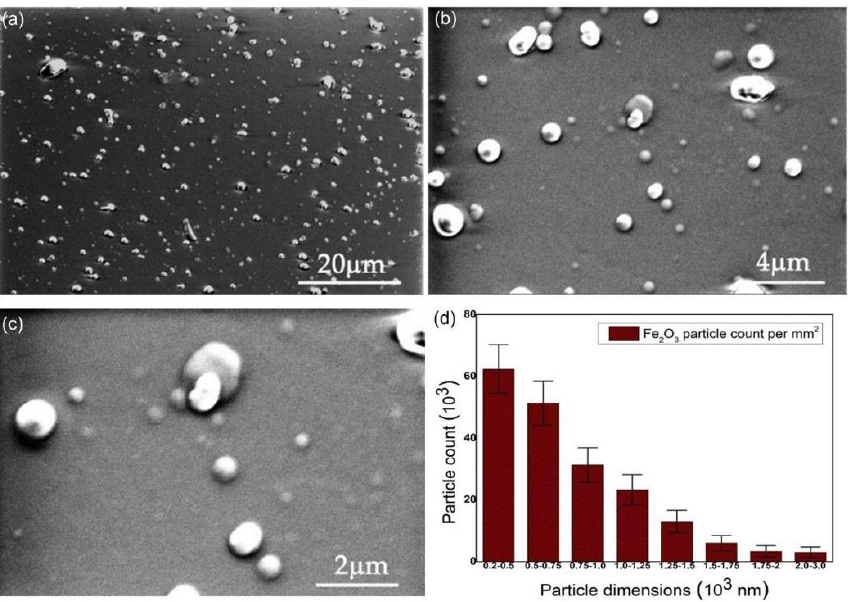
Figure 2. SEM images of PANI-IO film obtained by DC plasma polymerization at: ( a ) 2500×, ( b ) 10,000×, ( c ) and 20,000× magnifications. ( d ) The particle size distribution of iron oxide particles in PANI layers.